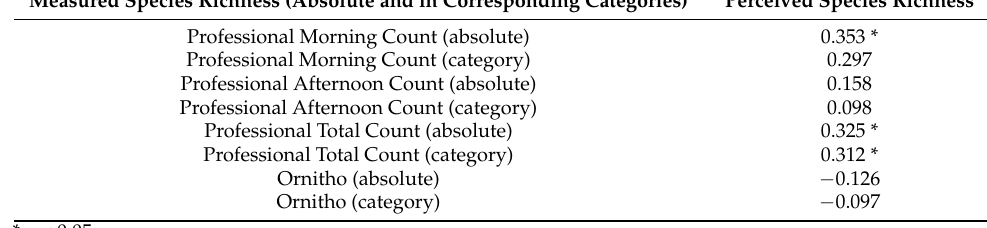
Table 1. Spearman-Rho correlation analysis results of the different bird count sources with the estimation of species present by laypeople. We repeated the analysis with the variables (absolute species richness) converted into the same categories as the laypeople’s assessment: 1 = 0–5; 2 = 6–10; 3 = 11–20; 4 = 21–30; 5 = 31–40; 6 = 41–50; 7 = 51–60; 8 = 61–70; 9 = over 70. Measured Species Richness (Absolute and in Corresponding Categories)